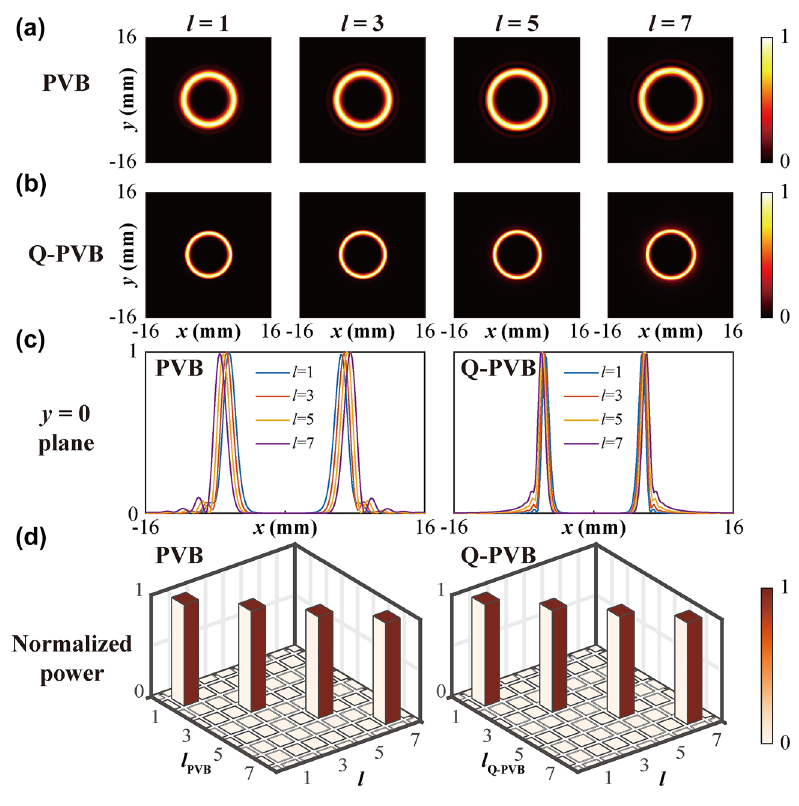
Figure 6: Calculated electric field intensity distributionofPVBsandQ-PVBswiththesame D and f at 0.75 THz. (a) Calculated intensity profiles of PVBs with the topological charges of l = 1, 3, 5, and 7 at the focal plane of z = 20 mm. (b) Corresponding intensity profiles of Q-PVBs. (c) Cross sections of annular intensity rings of PVBs and Q-PVBs. (d) Mode purities of PVBs and